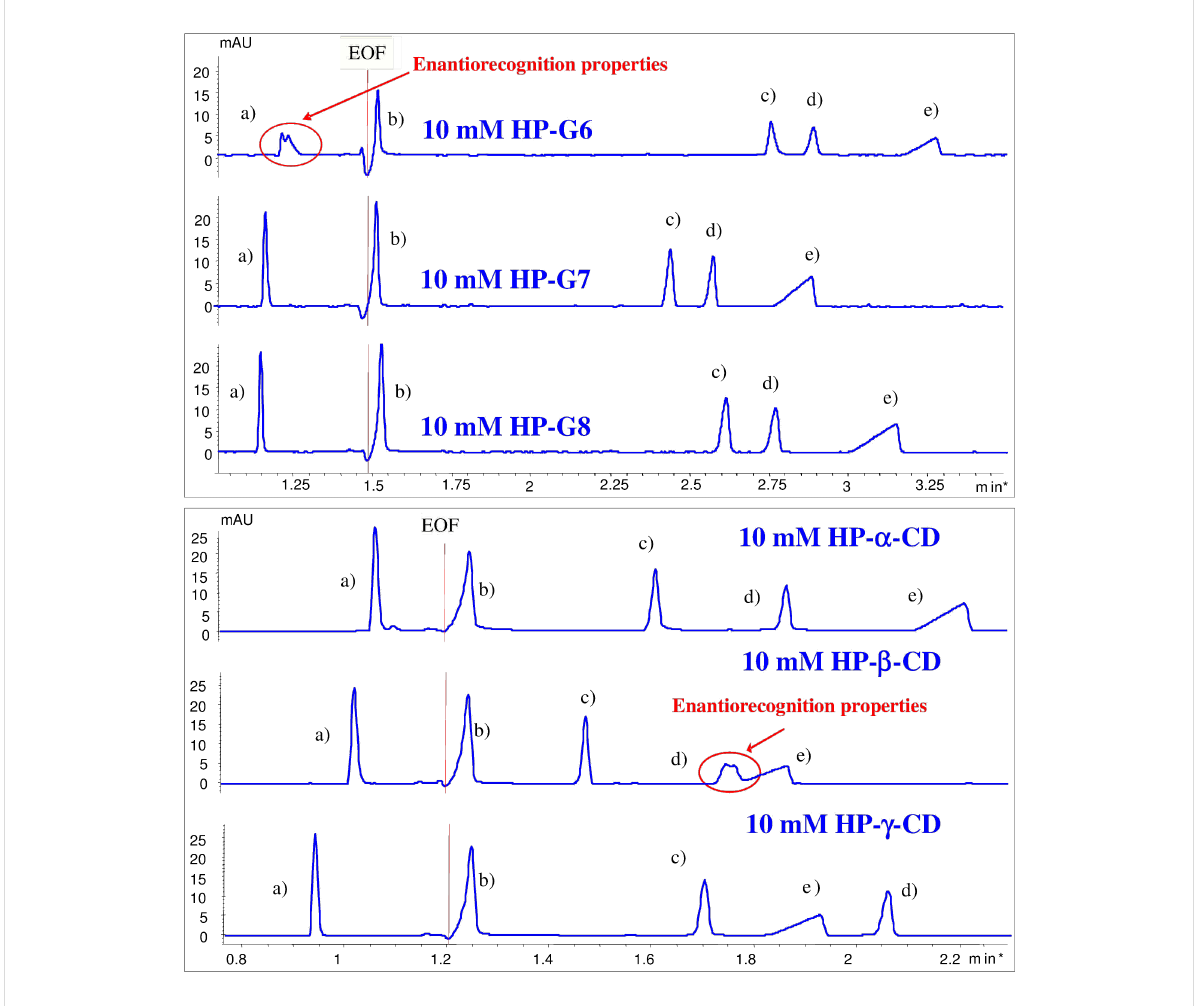
Figure 2: Electropherograms of tested model drugs in the presence of 2-hydroxypropylated acyclic and cyclic dextrins (assignments of the peaks are given in Table 2).